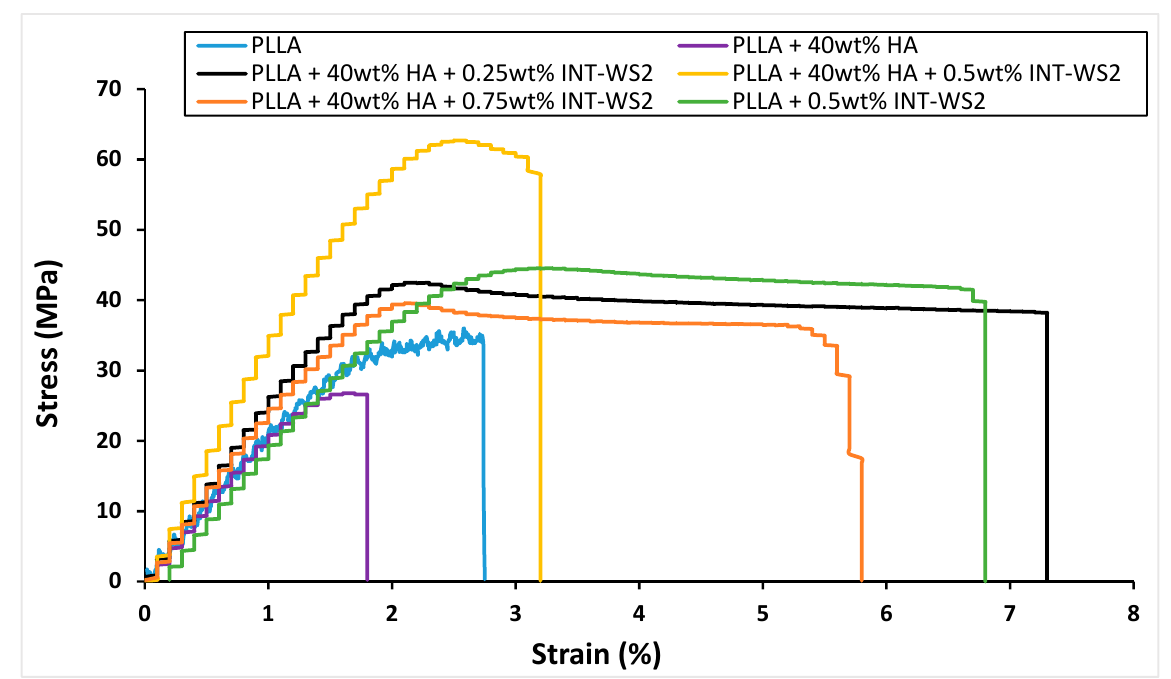
2 /PLLA nanocomposites.